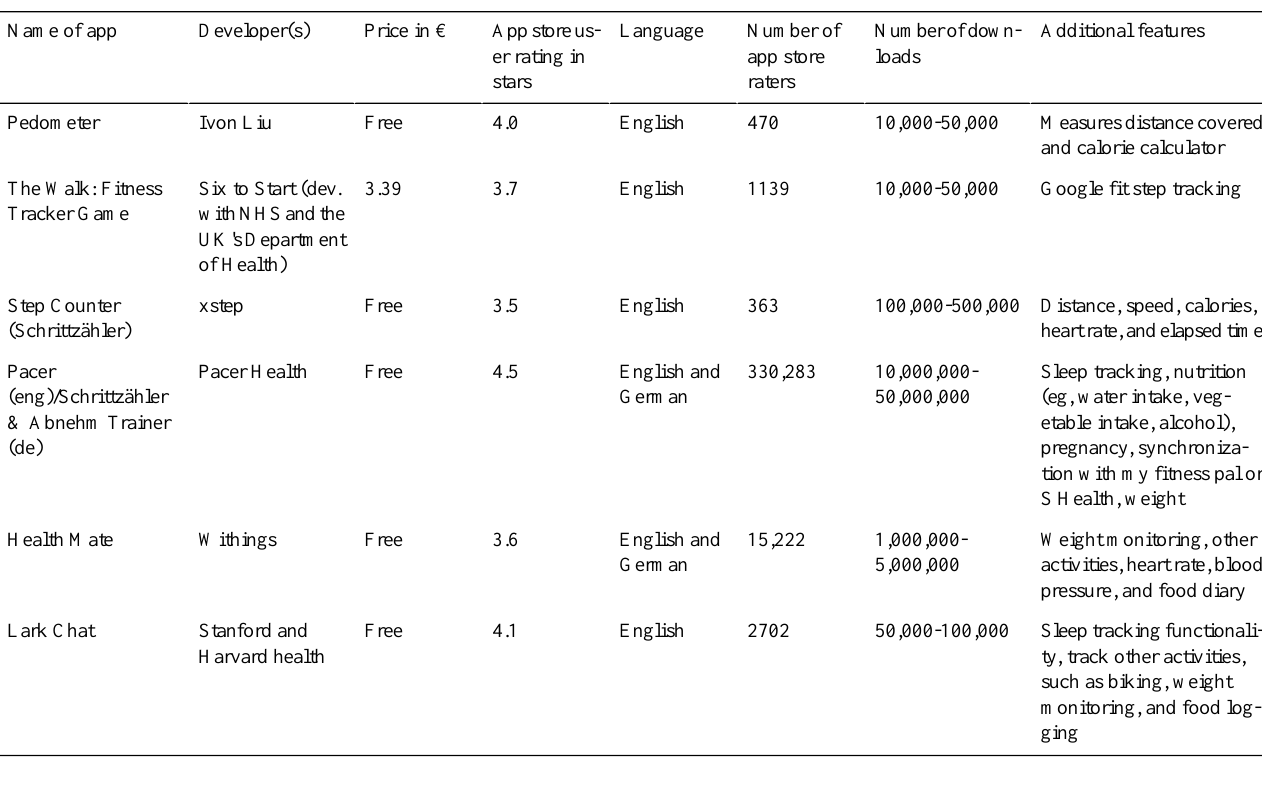
Table 1. Characteristics of physical activity and fitness apps.